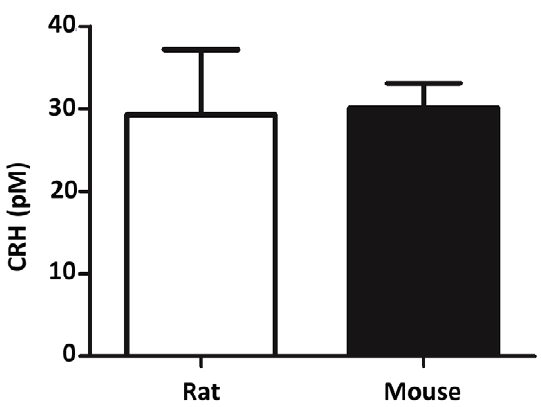
Figure 8. CRH protein levels are detectable in amniotic fluid from GD17 rat and GD15 mouse testis. CRH protein levels in amniotic fluid were measured using a fluorescent enzyme immunoas- say. Mean 6 SD are shown for all data. doi:10.1371/journal.pone.0047359.g008 genes increased at 6 hours. When treated with varying CRH concentrations for 6 hours in culture, steroidogenic mRNA levels